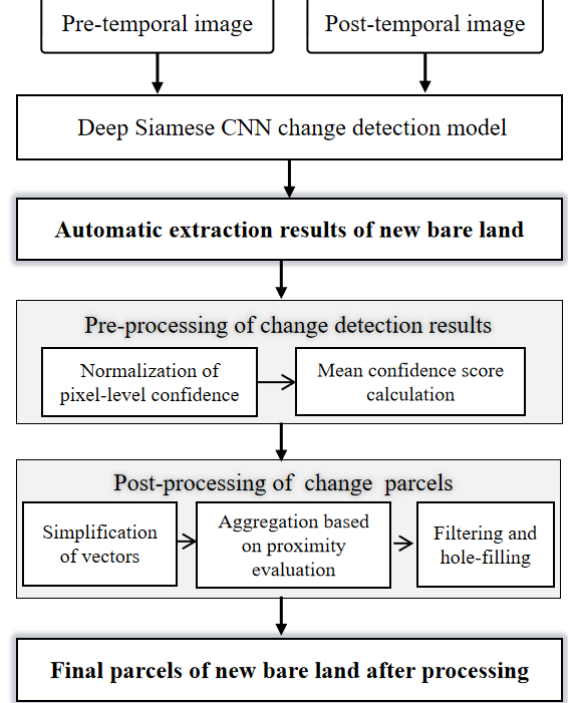
Figure 1. The overall workflow of the proposed methodology.